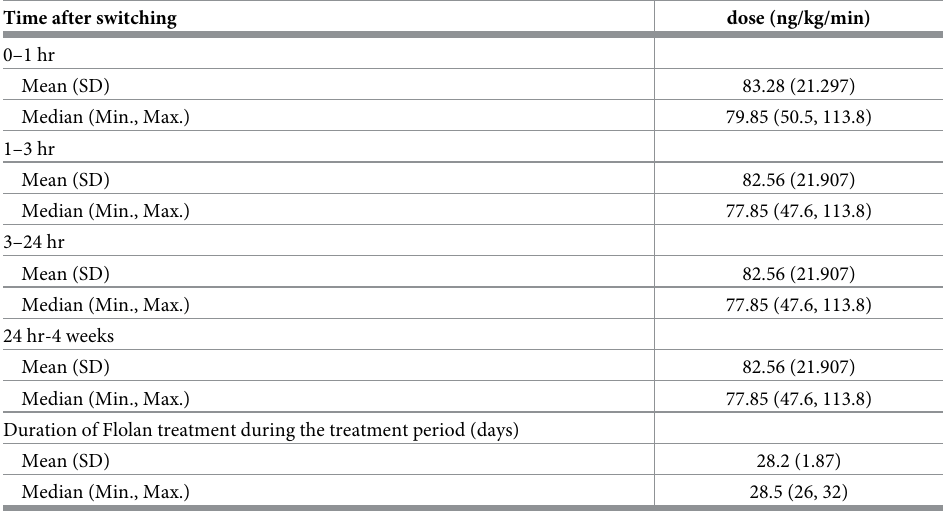
Table 2. Doses of Flolan after switching to Flolan solution prepared with the reformulated diluent (ITT population).